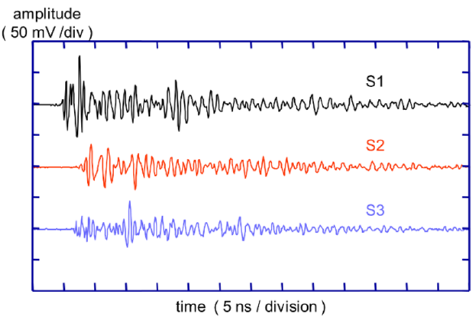
Figure 7. ( a ) Spectrum of a PD in bushing; ( b ) interturn short circuit.